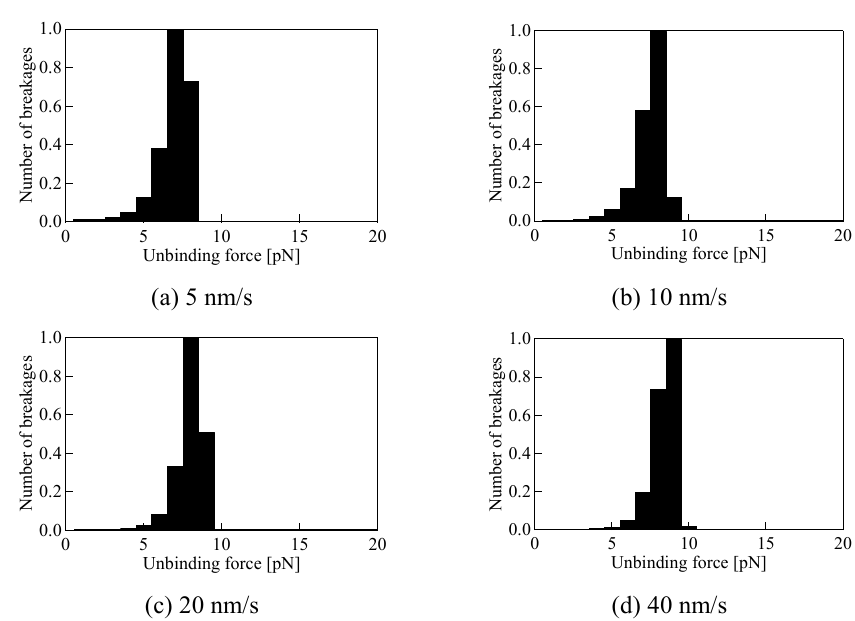
Fig. 5 Unbinding force distribution of single GPIb α –vWFA1 bond at different pulling rates between 5 and 40 nm/s.